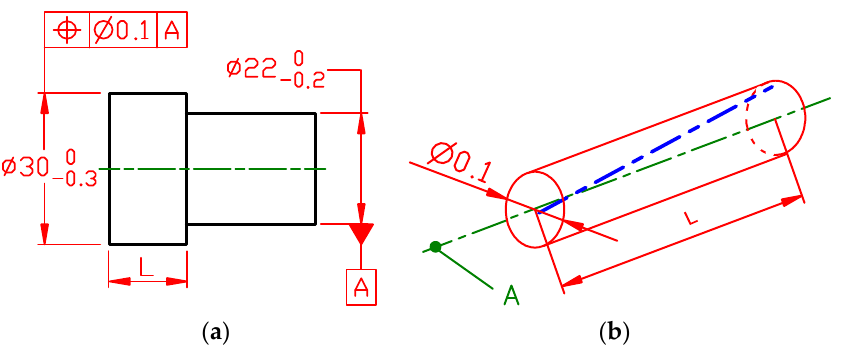
Figure 11. ( a ) Specification of position tolerance for flange with respect to the datum axis (ASME Y14.5); ( b ) minimum circumscribed cylinder axis shall be within the cylindrical tolerance zone.